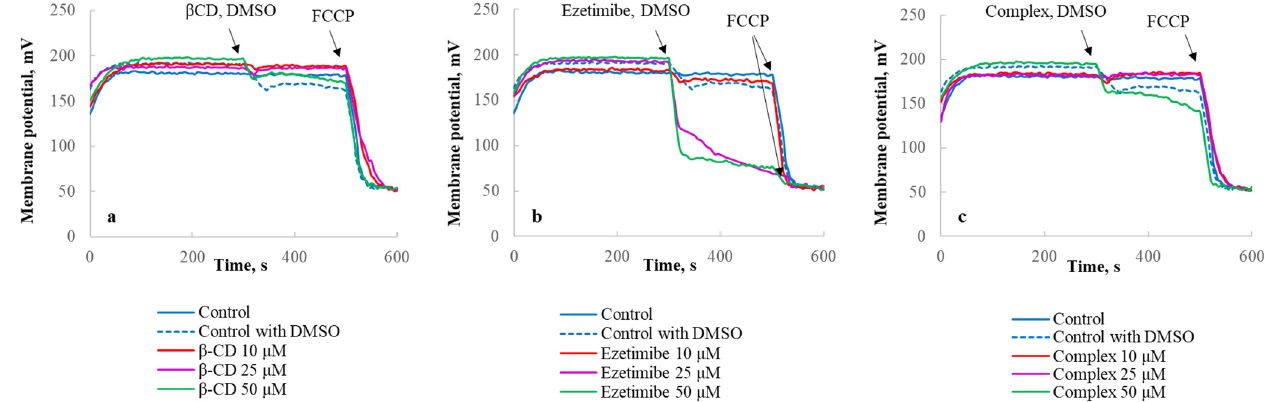
Figure 14. Representative traces of time-dependences of β -CD ( a )/ezetimibe ( b )/complex ezetimibe- β -CD ( c )—induced dissipation of mitochondrial membrane potential. The arrows indicate additions of DMSO/ β -CD/ezetimibe/complex ezetimibe- β -CD/FCCP to mitochondria suspension (0.3 mg of protein/mL) in the medium: 0.05 M sucrose, 0.125 M KCl, 0.01 M Tris–HCl, 0.0025 M KH 2 PO 4 , 0.005 M MgSO 4 , and 0.001 M EDTA, pH 7.5, at 27 ◦ C. The mitochondrial membrane potential was detected using the fluorescent dye safranin O (8 µ M) at λ ex/ λ em 495/586 nm at 27 ◦ C and 5 mM succinate as